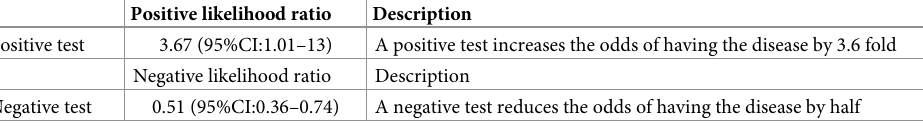
Table 2. Likelihood ratios and posterior probabilities after near infrared spectroscopy with vascular occlusion test (diseased vs.